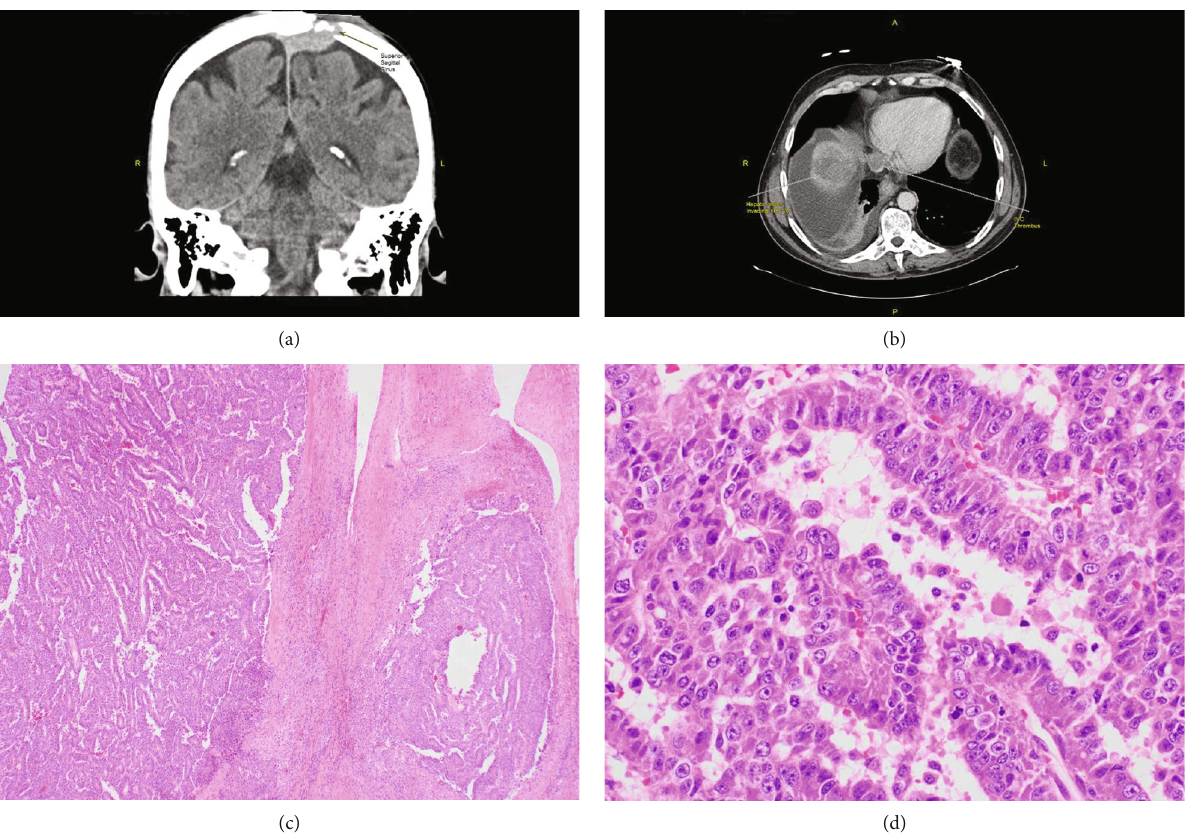
Figure 1: (a) Head CT (coronal view) revealing superior sagittal sinus-based tumor eroding through the cranium. (b) Abdominal CT revealing a heterogenous hepatic lesion invading the inferior venae cava with retrograde extension into the right atrium. (c) Histopathology of cranial tumor showing a characteristic trabecular pattern with thickened cords of cells separated by vascular sinusoids, mimicking the cell plates and sinusoids of a normal liver. (d) Histopathology showing tumor cells with a polygonal shape with prominent nuclei and nucleoli, granular eosinophilic cytoplasm, and intercellular canaliculi resembling liver